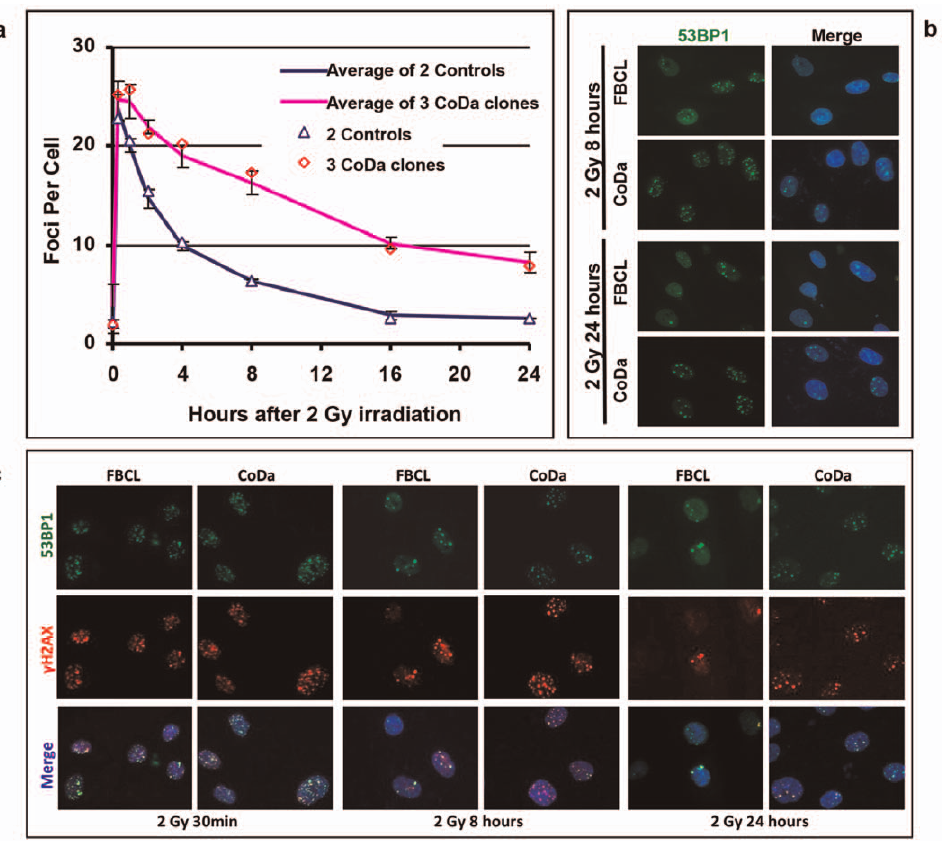
Figure 4. CoDa cells have normal IR-induced formations of 53BP1 nuclear foci, but displayed clearance of 53BP1 foci. The number of nuclear 53BP1 foci was scored at various time points after 2 Gy of c -irradiation in two control fibroblasts (FBCL and HSF42) and three CoDa populations (CoDa-2, CoDa-21, and CoDa-33). (a) The average number of 53BP1 foci from control fibroblasts ( D ) and their average (blue line), three CoDa populations ( e ) and their average (pink line). Shown are the averages of two experiments for each cell line. (b) The representative images of 53BP1 foci in the CoDa and FBCL cells at 8 and 24 hours after 2 Gy radiation treatment. DAPI staining shows the location of nuclear. In addition, double staining with 53BP1 and c H2AX antibodies was performed in FBCL and CoDa cells at various time points after 2 Gy of c -irradiation. (c) The representative images of 53BP1 and c H2AX foci in FBCL and CoDa cells at 30 min, 8 and 24 hours after 2 Gy of radiation treatment. DAPI staining shows the location of